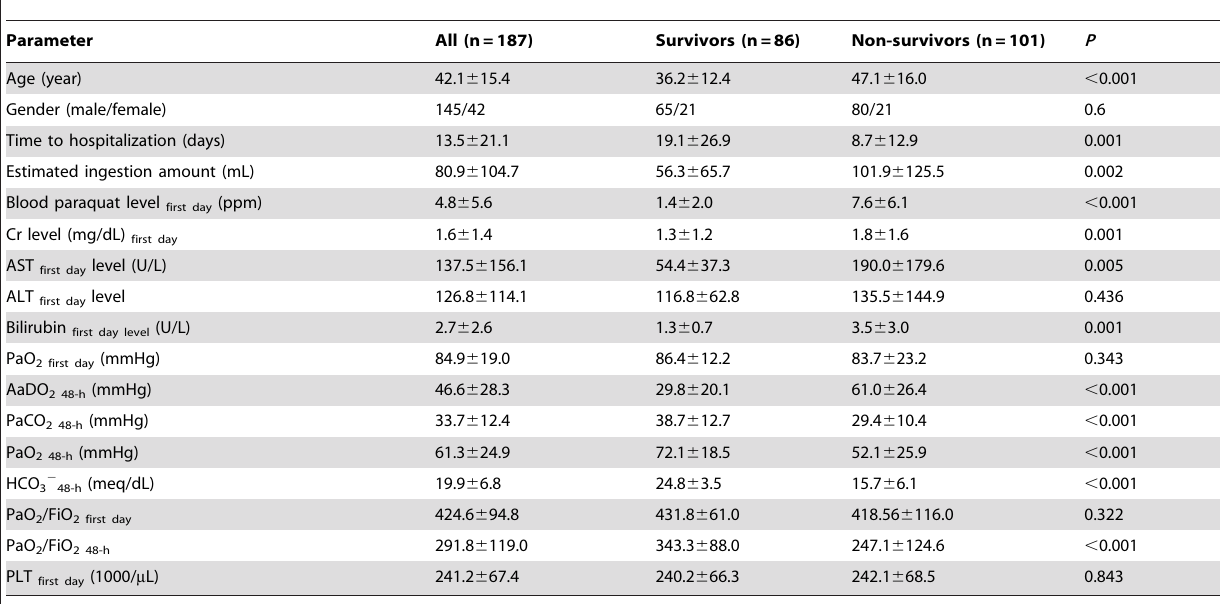
Table 3. Comparison of baseline demographics and clinical characteristics between survivors and non-survivors (n= 187).